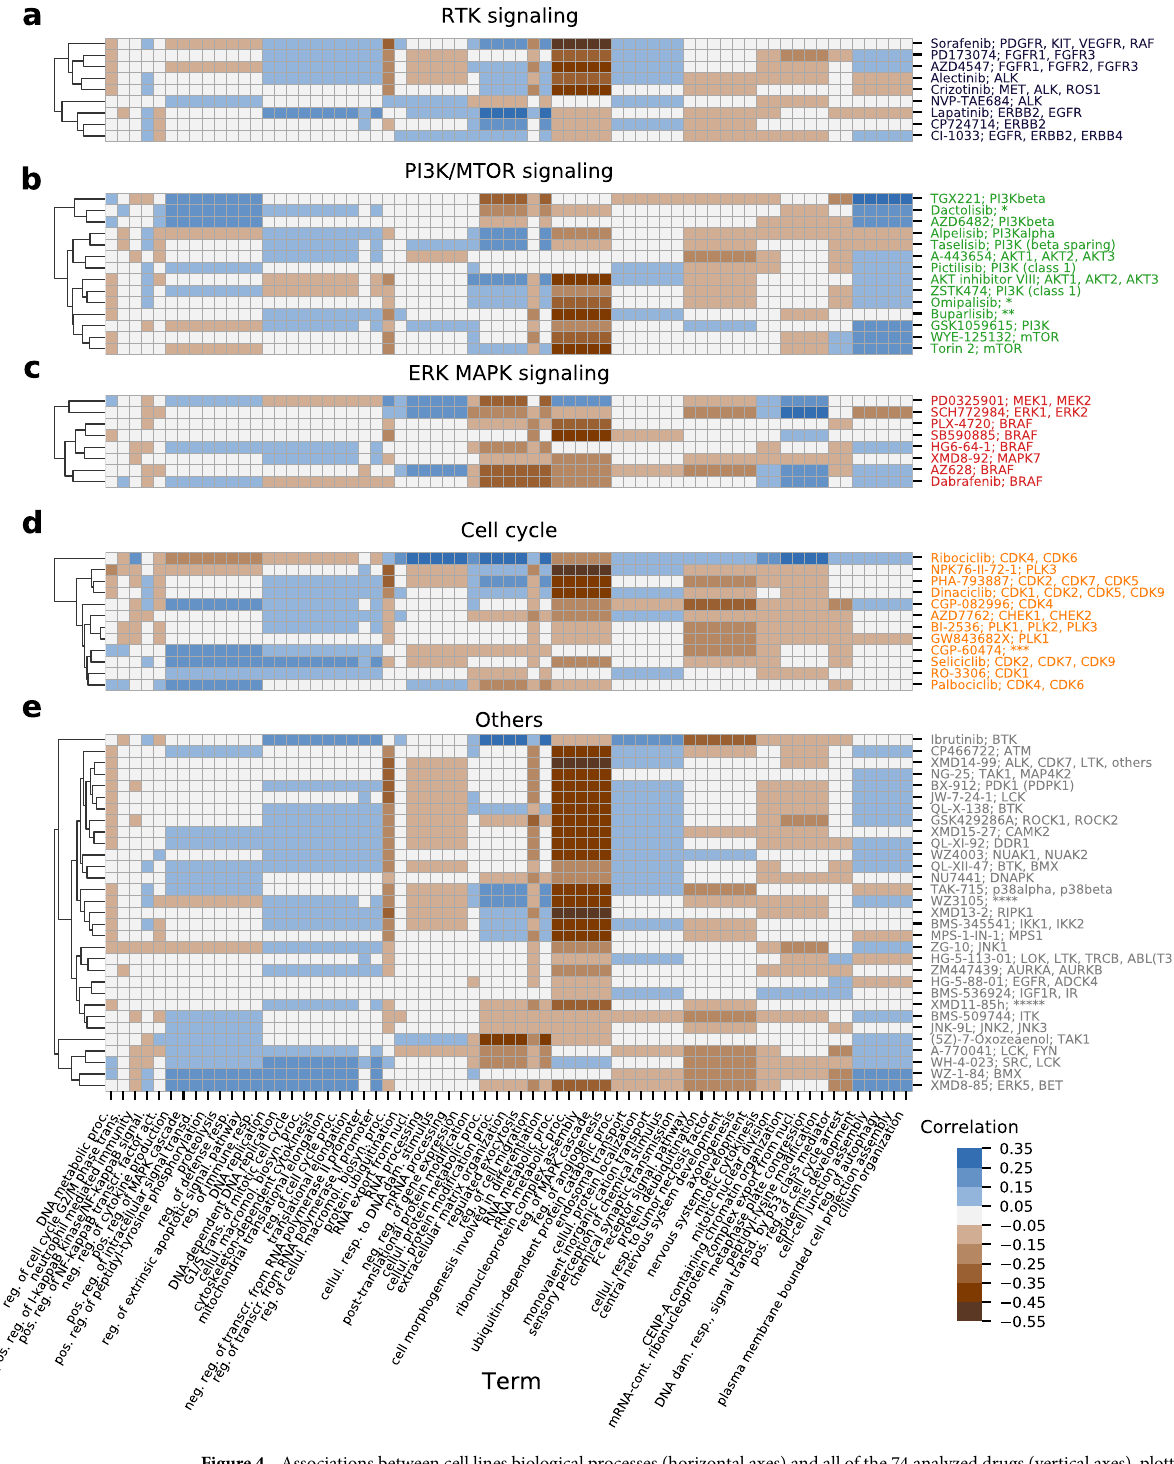
Figure 4. Associations between cell lines biological processes (horizontal axes) and all of the 74 analyzed drugs (vertical axes), plotted separately for ( a ) RTK signaling, ( b ) PI3K/MTOR signaling, ( c ) ERK MAPK signaling, ( d ) Cell cycle and ( e ) Others target pathways. First, for every drug, the Spearman correlation coefficient between every cell line hidden dimension and the response is computed, as shown in Fig. 3. These correlations are then assigned to biological processes associated with a given hidden dimension (see Fig. 2). If more than one hidden dimension is related to a process, an average of correlation is taken and assigned to the process. Drugs were hierarchically clustered using the Euclidean distance and average linkage within a given target pathway category. The horizontal axis is shared for all panels. The vertical axis tick label is formatted as: Drug Name; Putative Targets. Drugs target pathways and putative targets are taken from GDSC annotations. The labels are color-coded by the target pathway. For some drugs, putative targets have not been listed for readability. Those targets are: * – PI3K (class 1), MTORC1, MTORC2, ** – PI3Kalpha, PI3Kdelta, PI3Kbeta, PI3Kgamma, *** – CDK1,CDK2,CDK5,CDK7,CDK9, PKC, **** – RC, ROCK2, NTRK2, FLT3, IRAK1, others, ***** –